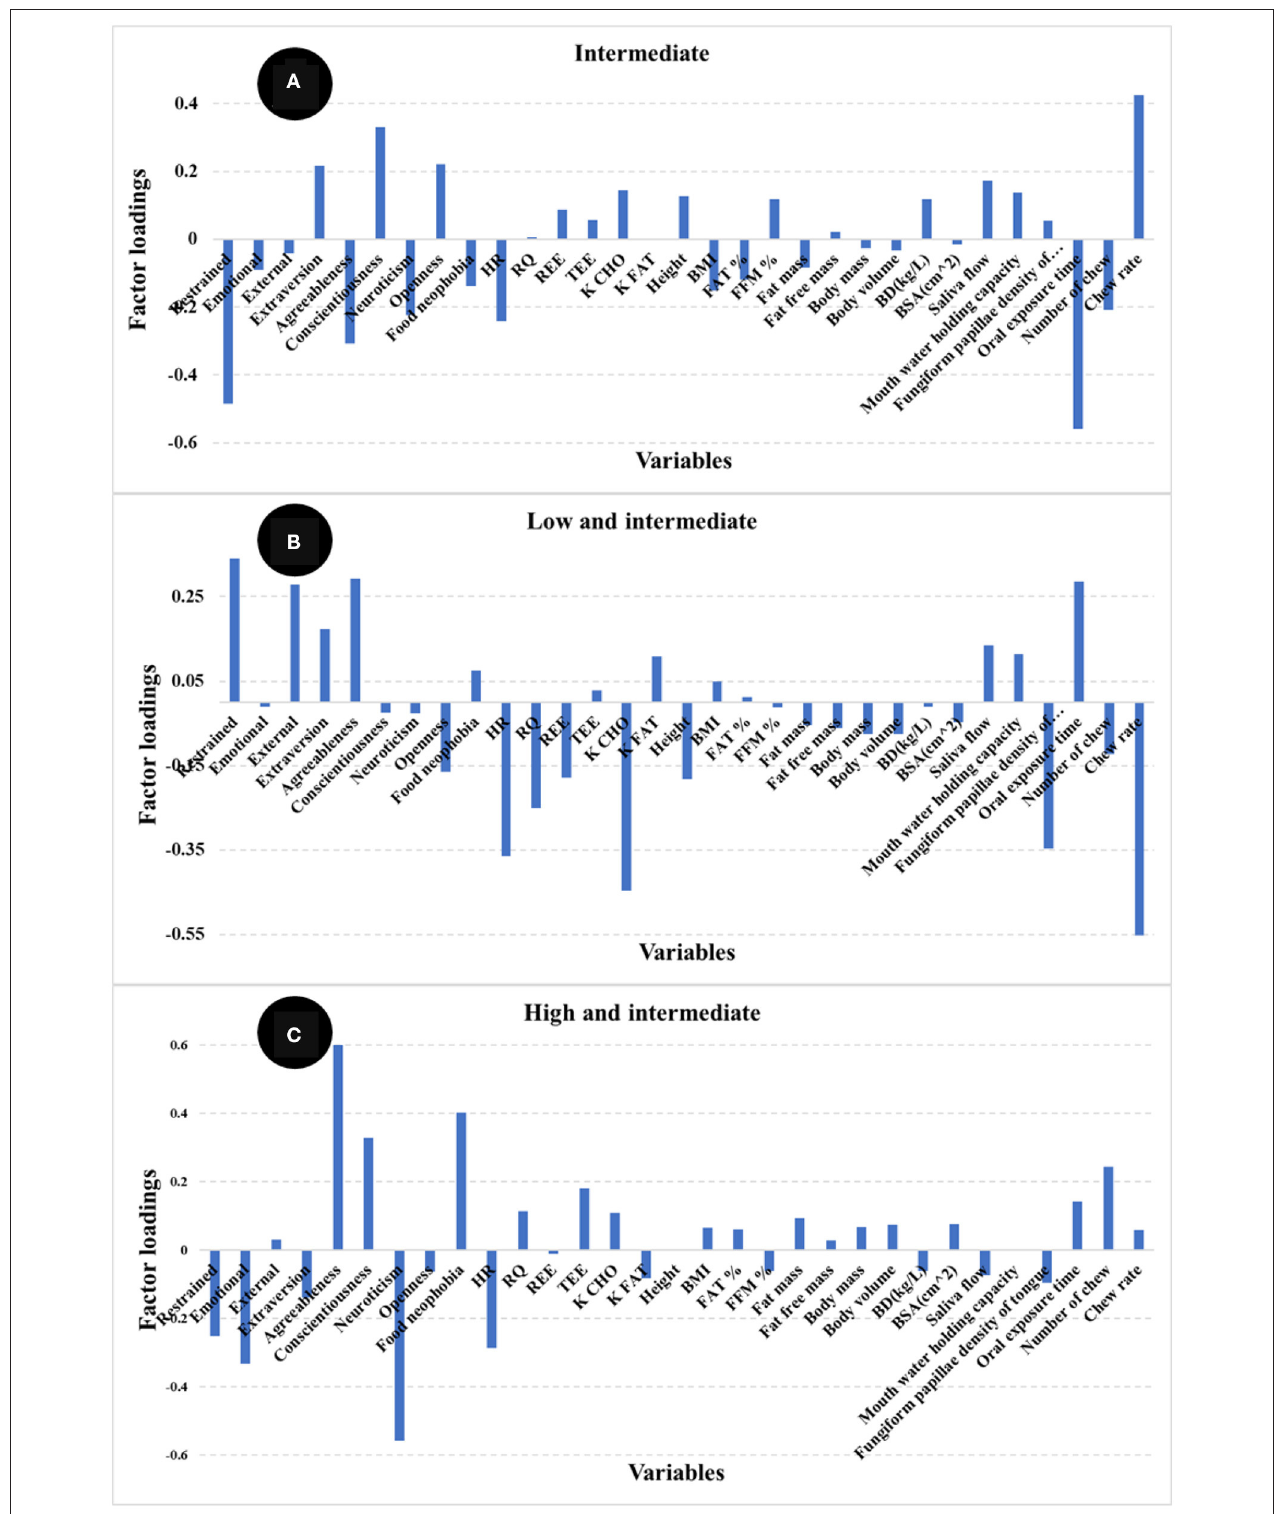
FIGURE 9 | Loadings for PLS regression models comparing satiety phenotypes [ (A) intermediate satiety phenotype, (B) . low and intermediate satiety phenotype, and (C) high and intermediate satiety phenotype].